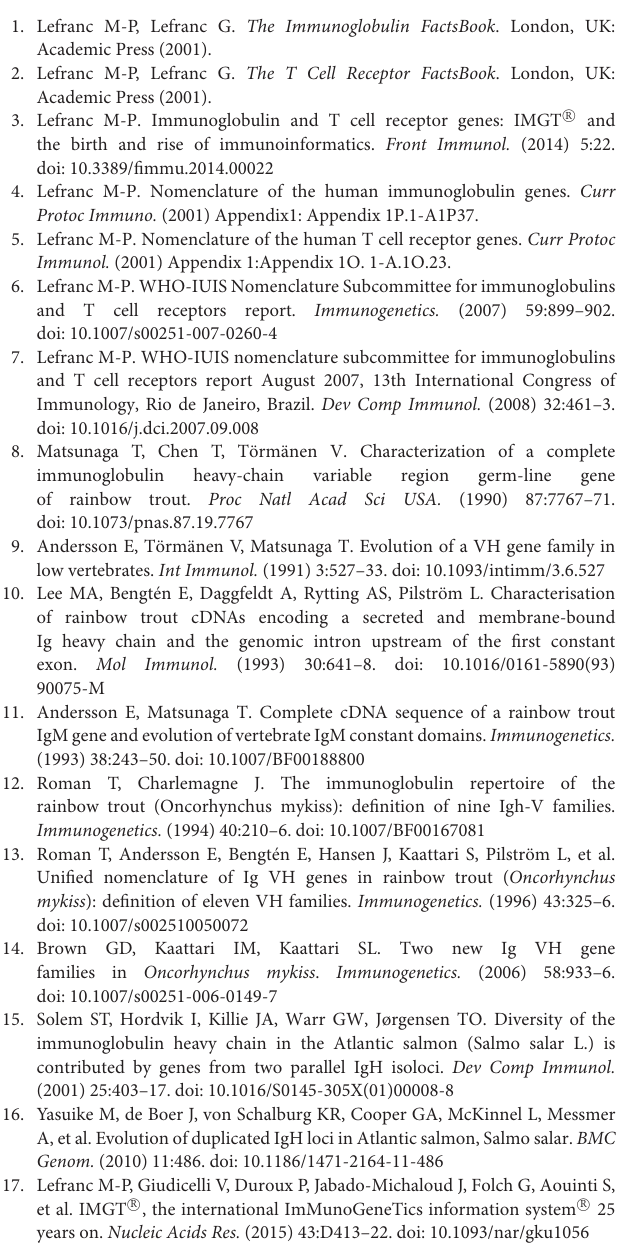
Figure S2 | Alignment of the J-REGION amino acid sequences of the IGHJ (joining) genes located upstream of the IGHM or IGHT (locus A) and IGHMD or IGHTD (locus B) genes of Salmo salar (Salsal) and Oncorhynchus mykiss (Oncmyk). Genes of the locus B are identified by the letter D which follows the gene number. Labels are according to the J-GENE prototype (IMGT Scientific chart > 1. Sequence and 3D structure identification and description > IMGT prototypes table > J-GENE) 1 . The highly conserved FDYWGKGTXVT motif is pink highlighted and those residues that deviated from it are in